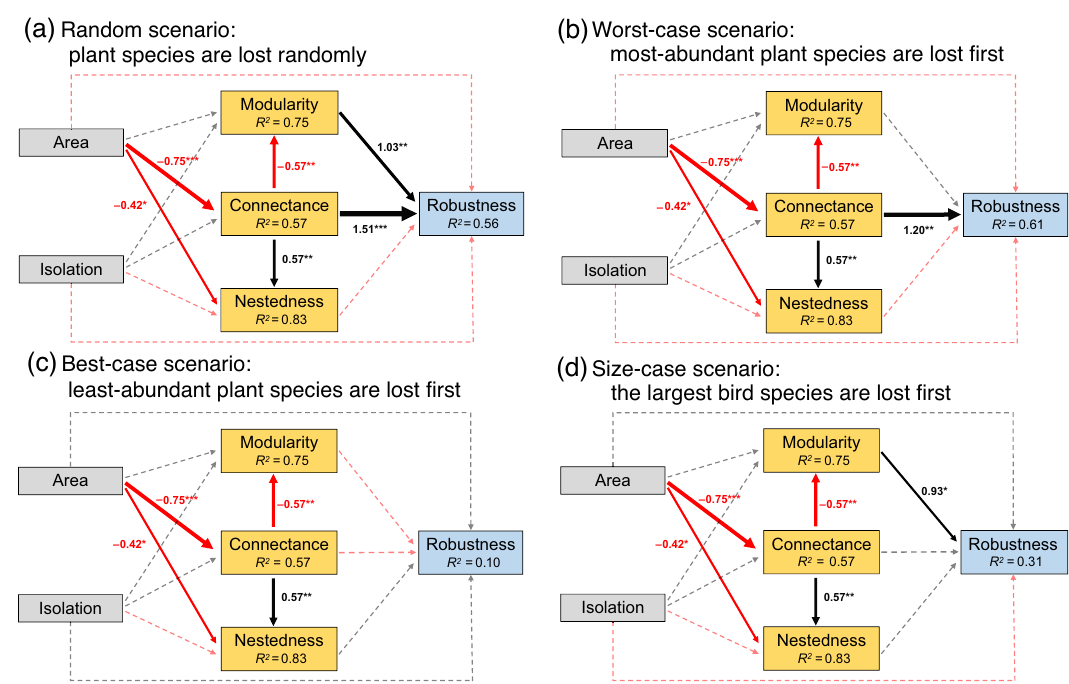
Fig. 5 Path diagrams for four scenarios of the effects of island area and isolation on the structure and stability of plant-frugivore networks in the Thousand Island Lake, China. a Random scenario, b Worst-case scenario, c Best-case scenario and d Size-case scenario. The solid lines indicate signi fi cant paths, whereas dotted lines represent non-signi fi cant paths. Black arrows represent positive effects and red arrows represent negative effects. Numbers alongside each path are standardised coef fi cients. Signi fi cant effects are depicted for * p < 0.05, ** p < 0.01, and *** p < 0.001. Conditional R 2 values are given in the boxes. Fisher ’ s C = 2.659, p =